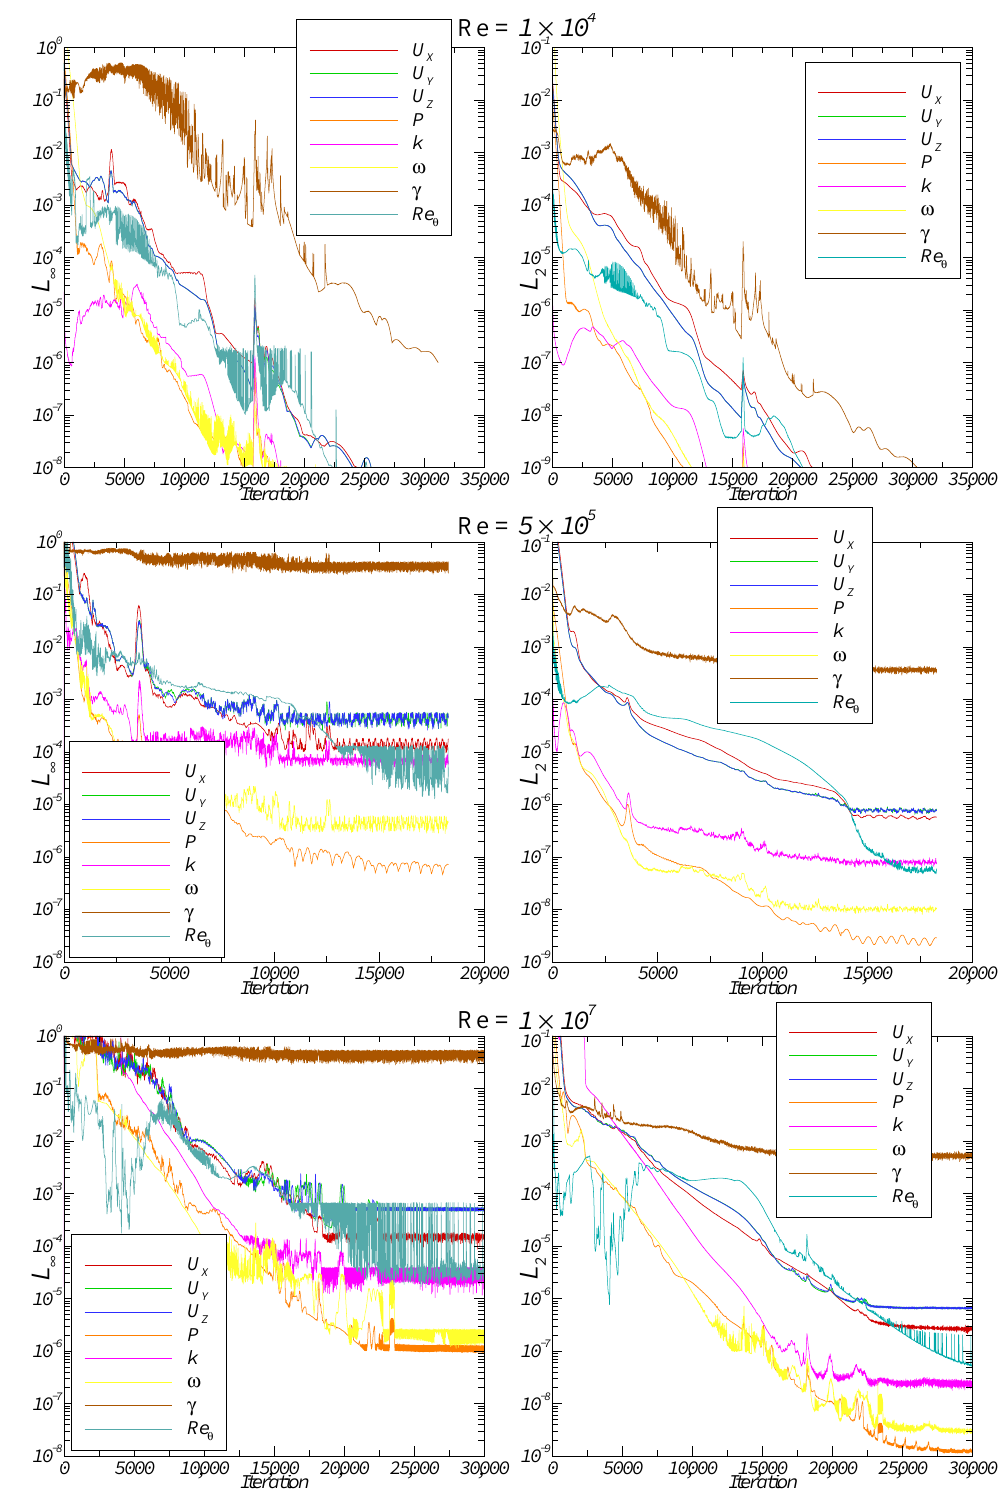
Figure 3. L ∞ ( left ) and L 2 ( right ) iterative convergence at J = 0.568 using the γ − ˜Re θ model. Re = 1 × 10 4 ( top ), 5 × 10 5 ( middle ) and 1 × 10 7 ( bottom